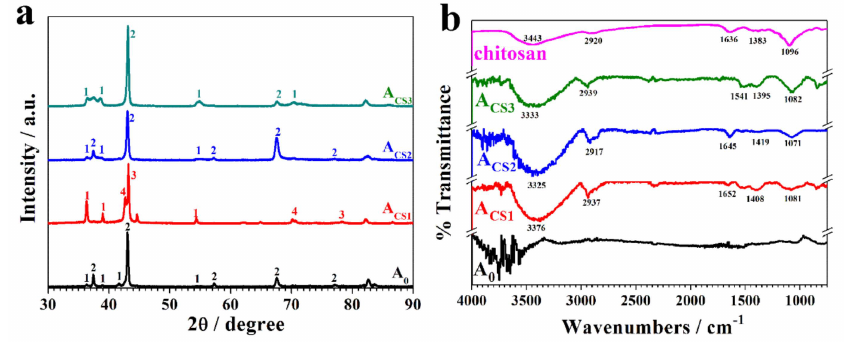
Figure 5. ( a ) XRD patterns and ( b ) the FT-IR spectrum of A 0 , A CS1 , A CS2 , A CS3 , and chitosan. 1: Reflection peaks of the Zn crystal; 2: Reflection peaks of the η -phase Zn–Ni alloy crystal; 3: Reflection peaks of the γ -phase Zn-Ni alloy crystal; 4: Reflection peaks of the δ -phase Zn-Ni alloy